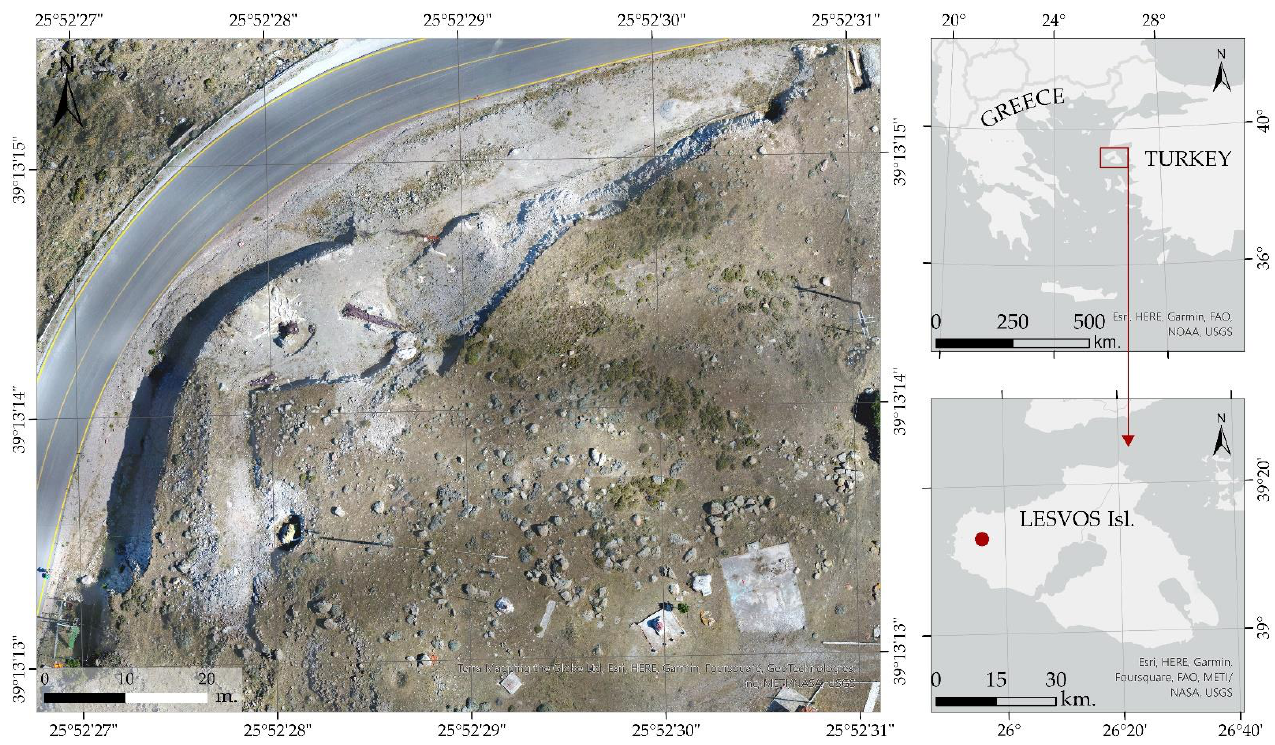
Figure 1. Location of the fossilite ferrous site, Lesvos Petrified Forest, Lesvos, Greece (Sources: Esri, HERE, Garmin, FAO, METI/NASA, USGS).